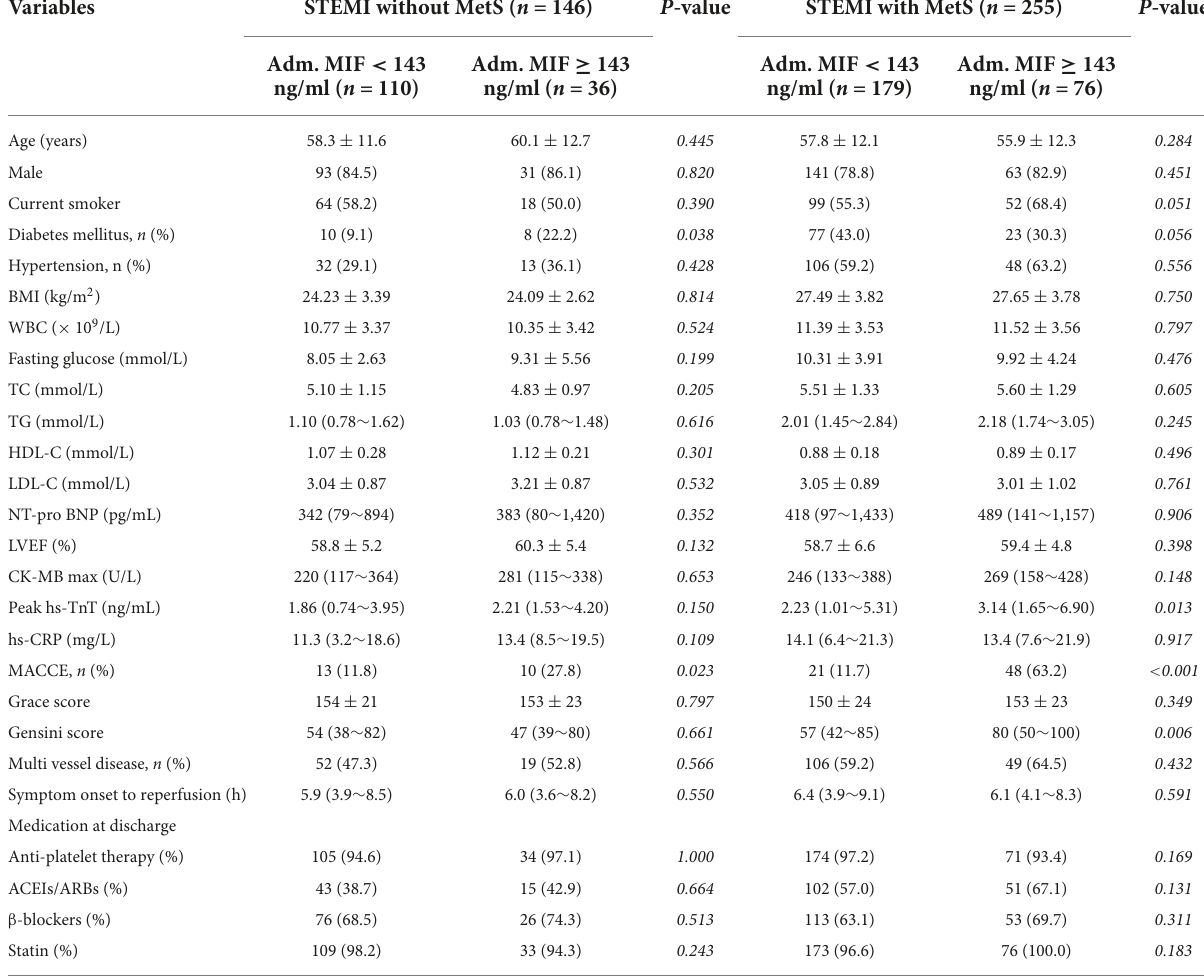
TABLE 3 Baseline clinical characteristics of STEMI patients with or without MetS grouped by the cut-off value of adm. MIF (143 ng/ml).